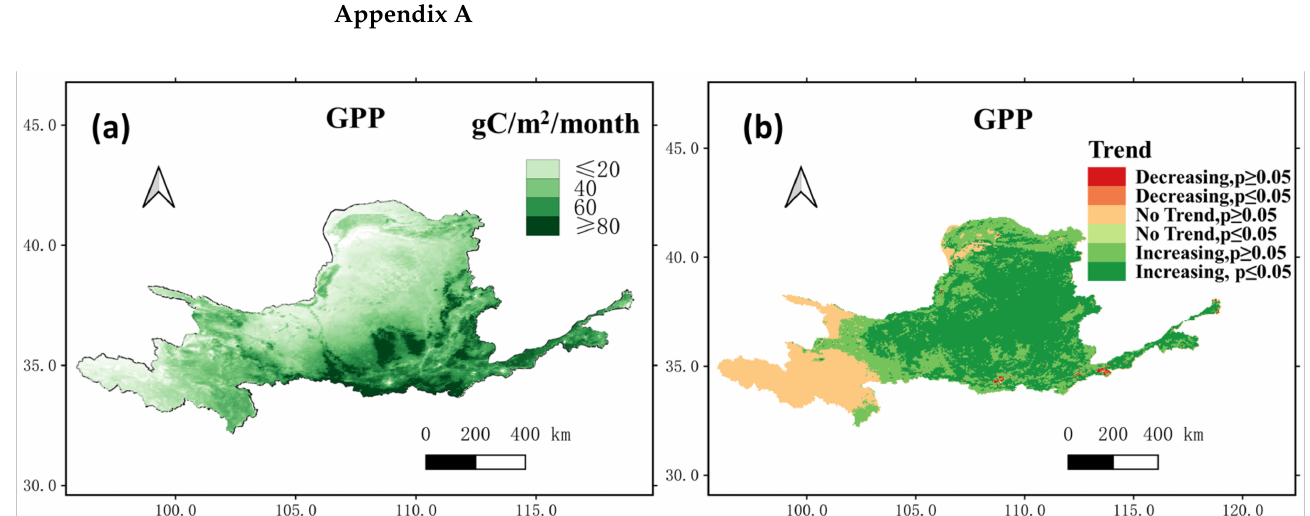
Figure A1. ( a ) Spatial variations and ( b ) trends in monthly mean GPP in the YRB; sourced from MOD17A2H.